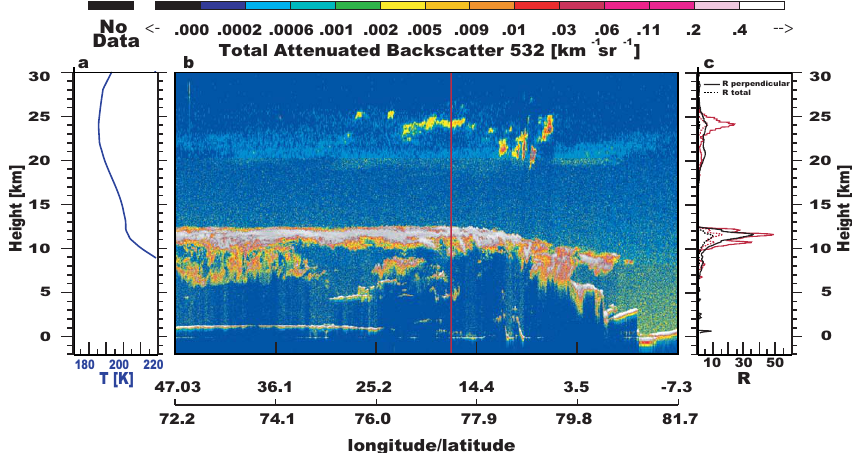
Fig. 1. Observation of an inhomogeneous PSC on the 2 January 2008 over an deep-tropospheric cloud system in terms of a time-height display of the attenuated backscatter coefficient at 532nm as observed by the CALIPSO lidar between 08:49 and 09:35UTC. (a) The mean stratospheric temperature over the longitude and latitude range of the observed PSC is shown on the left side. The red line in the total attenuated backscatter plot (b) shows an example for the mean position for the average calculation of the backscatter ratio. (c) The backscatter ratio perpendicular (red dotted line 1.5 ◦ average, black dotted line 10 ◦ average), and parallel (red solid line 1.5 ◦ average, black solid 10 ◦ average).